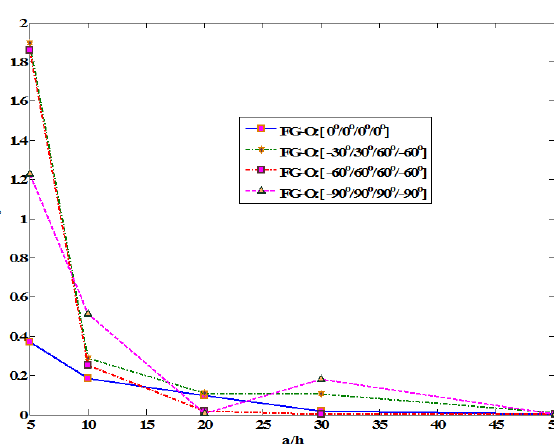
Figure 4: The non-dimensional deflection W o for angle–ply [- θ / θ / θ /- θ ] UD plate with different lamination scheme Figure 5 shows non-dimensional central deflections (W 0 ) versus width-to-thickness ratio for different lamina- tion scheme with FG-O distribution of plate subjected to uniform transverse loading (q 0 ). The results clearly show that the non-dimensional central deflection decrease with an increase the width-to-thickness ratio. All lamination schemes have significant results of the a/h ratio up to 20 and the rest of the value is constant. Figure 6 present non- dimensional central deflections (W 0 ) versus width-to-thickness ratio for different lamina- tion scheme with FG-V distribution of plate subjected to uniform transverse loading (q 0 ). The results clearly show that the non-dimensional central deflection decrease with an increase the width-to-thickness ratio. Because of a/h > 20 plate is thin and plate a/h < 20 plate is thick. However,